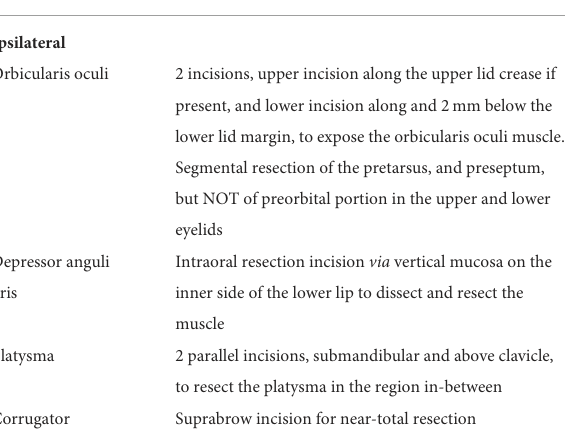
TABLE 7 Typical targets for a facial muscle myectomy and facial nerve branch neurectomy.